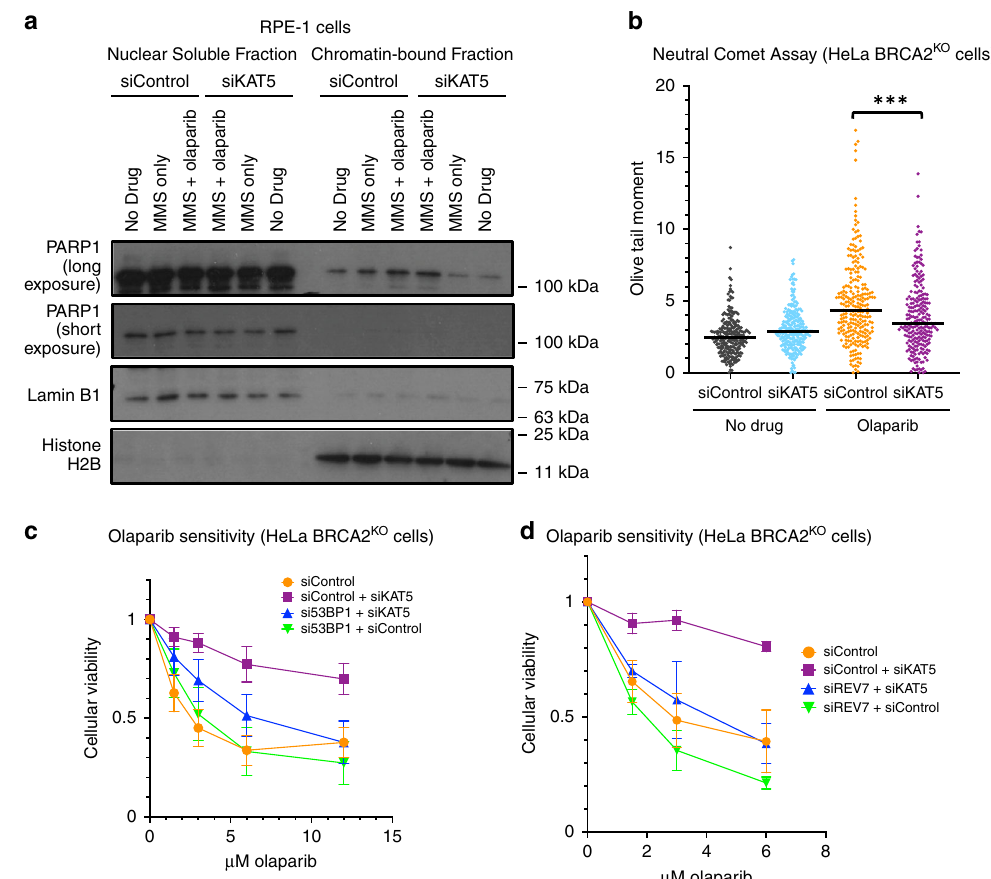
Fig. 5 KAT5 depletion reduces olaparib-induced double-strand breaks and relies on the 53BP1/REV7 pathway to rescue olaparib-induced cytotoxicity. a Chromatin fractionation experiment shows that while MMS (0.01%) and olaparib (1 μ M) co-treatment for 3 h induces trapping of PARP1 on the chromatin, this effect is not rescued by KAT5 depletion. An independent replicate experiment is shown in Supplementary Fig. 9a. b Neutral comet assay showing that olaparib treatment (10 μ M for 24 h) induces double-strand breaks in HeLa BRCA2-knockout cells, and that this effect is abrogated by KAT5 depletion. At least 120 comets from each of two experiments were pooled for each sample. Medians are shown as horizontal bars. Asterisks indicate statistical signi fi cance (Mann – Whitney test, two-sided). c PARPi resistance caused by KAT5 depletion is dependent on 53BP1. The averages of nine experiments are shown, with standard deviations as error bars. d REV7 is required for the PARPi resistance after KAT5 knockdown. The averages of three experiments are shown, with standard deviations as error bars. Source data are provided as a Source Data fi